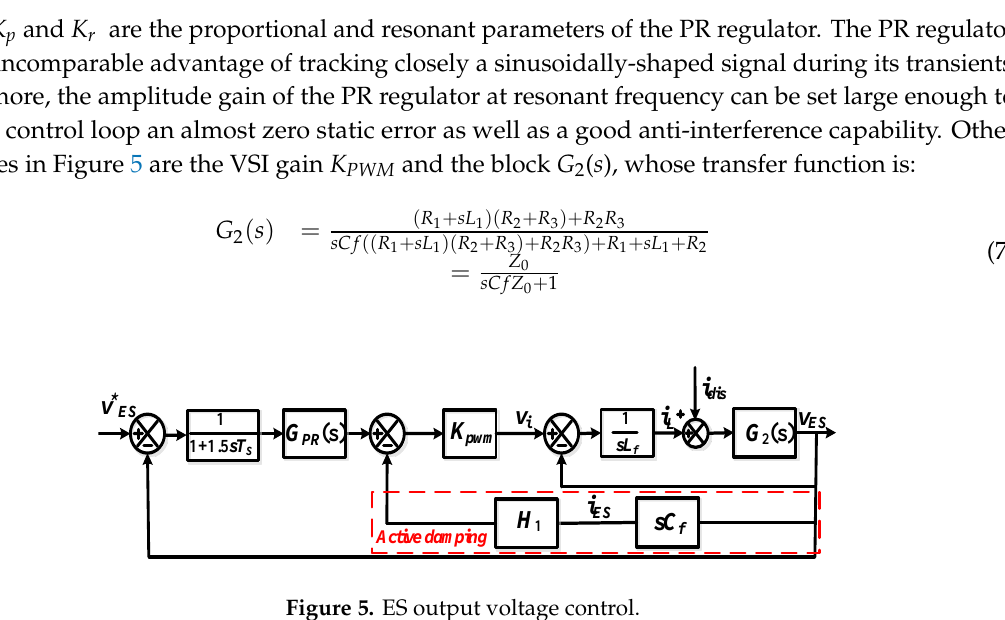
Figure 5. ES output voltage control.